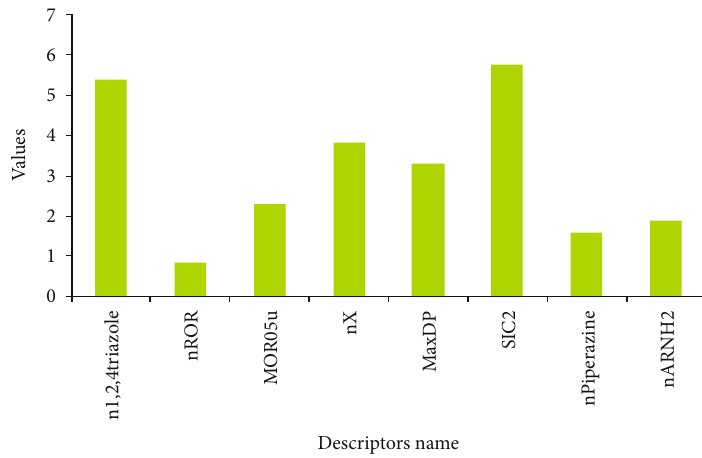
Figure 2: PLS regression coe ffi cients for selected descriptors in GA-PLS Table 3: Structural modi fi cation of studied compounds and their predicted activities and docking binding energies based on GA-PLS